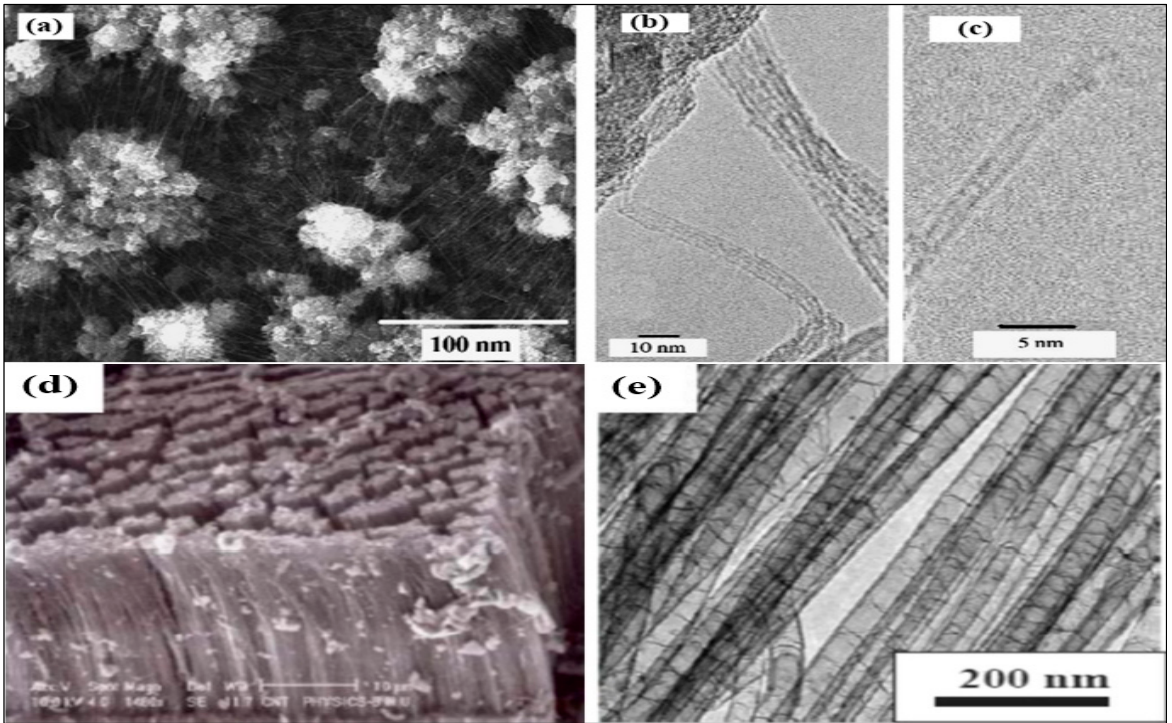
Figure 4. The various types of natural precursors, edible food, and scrap material employed for the fabrication of numerous new innovative carbon nanostructures.